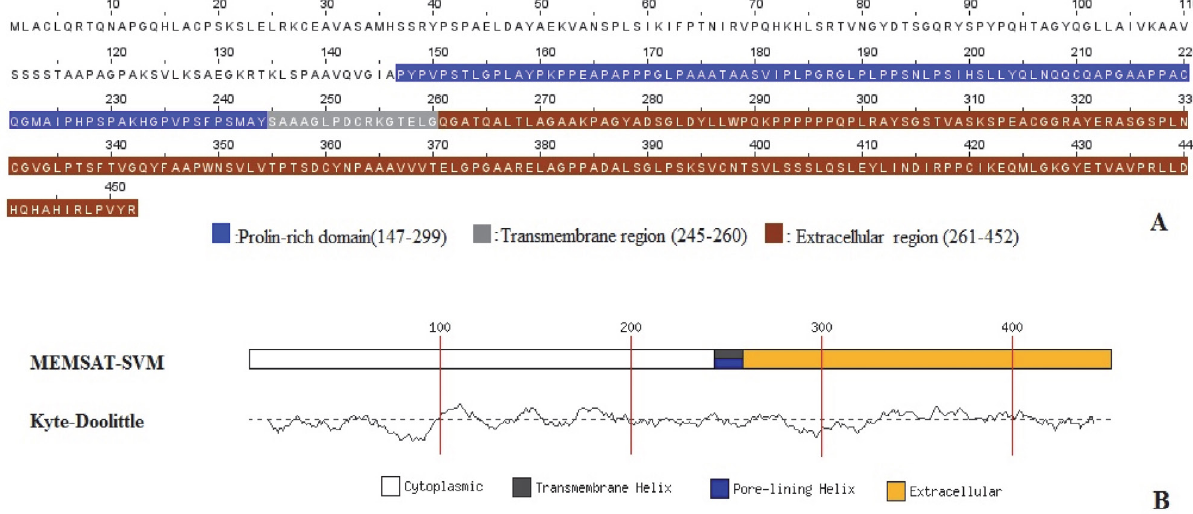
Figure 2. A.) The primary structure of FAM222A encoded Aggregatin protein. PSIPRED was used to predict the actual primary structure. The cy- toplasmic part is colorless, the proline-rich region(147–299) gained from the UniProt tool is colored with navy blue. The transmembrane region (245–260 residues) is gray and the extracellular part region (261–452) is colored with brown. B.) MEMSAT-SVM shows the transmembrane helix topology and the Kyte-Doolittle scale presents the hydrophobic amino